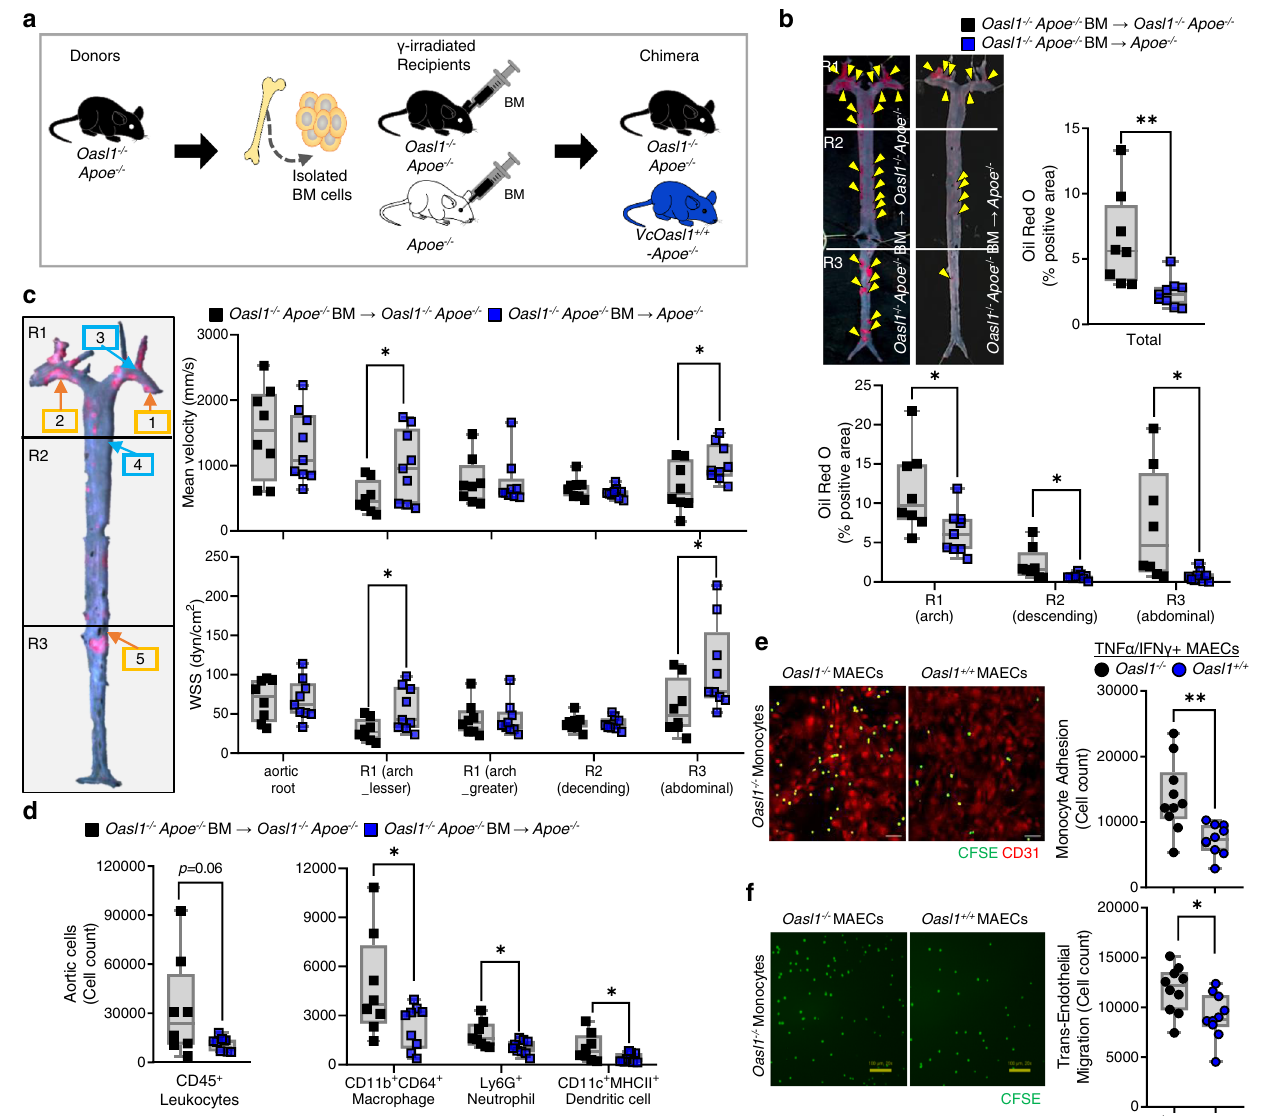
Fig. 8 | Endothelial OASL1 attenuates leukocyte recruitment and lesion for- mation. a – d Rescue effects of Oasl1 in vascular cell types were assessed by reconstituting γ -irradiated Oasl1 − / − Apoe − / − and Apoe − / − micewith bone marrow (BM) from Oasl1 − / − Apoe − / − micefollowedbyanormalchowdiet(NCD)for28weeks( n =8 for Oasl1 − / − Apoe − / − ;n=9forVc Oasl1 +/+ -Apoe − / − ). a Experimentalscheme. b Leftpanel: Oil red O-stained lesions in whole aortas. Yellow arrowhead: plaque in aorta. Right panel: Quanti fi cation of stained en face area. Bottom panel: Separate quantitation of Oil red O + areas in aortic arch (R1), descending (R2) and abdominal (R3) regions (Total: p =0.0058, R1: p =0.0203, R2: p =0.0310, R3: p =0.0159). c Blood fl ow velocity (top) and endothelial wall shear stress (WSS; bottom) at the athero- resistant greater curvature, descending and athero-prone lesser curvature, or abdominal branching point of arteries were assessed in age-matched 20-week-old mice prior to identi fi cation of plaque formation by serial echocardiography